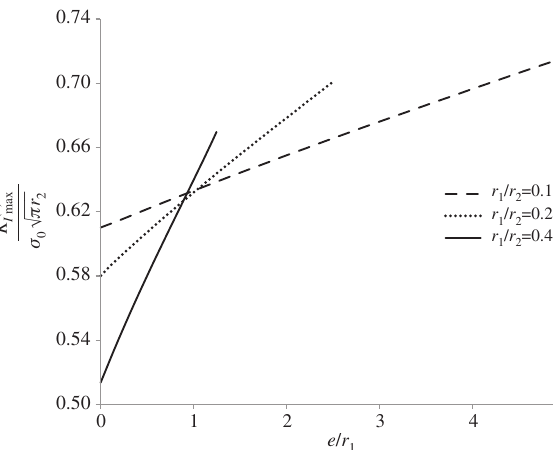
= 0.1, 0.2, and 0.4. / r 1 2